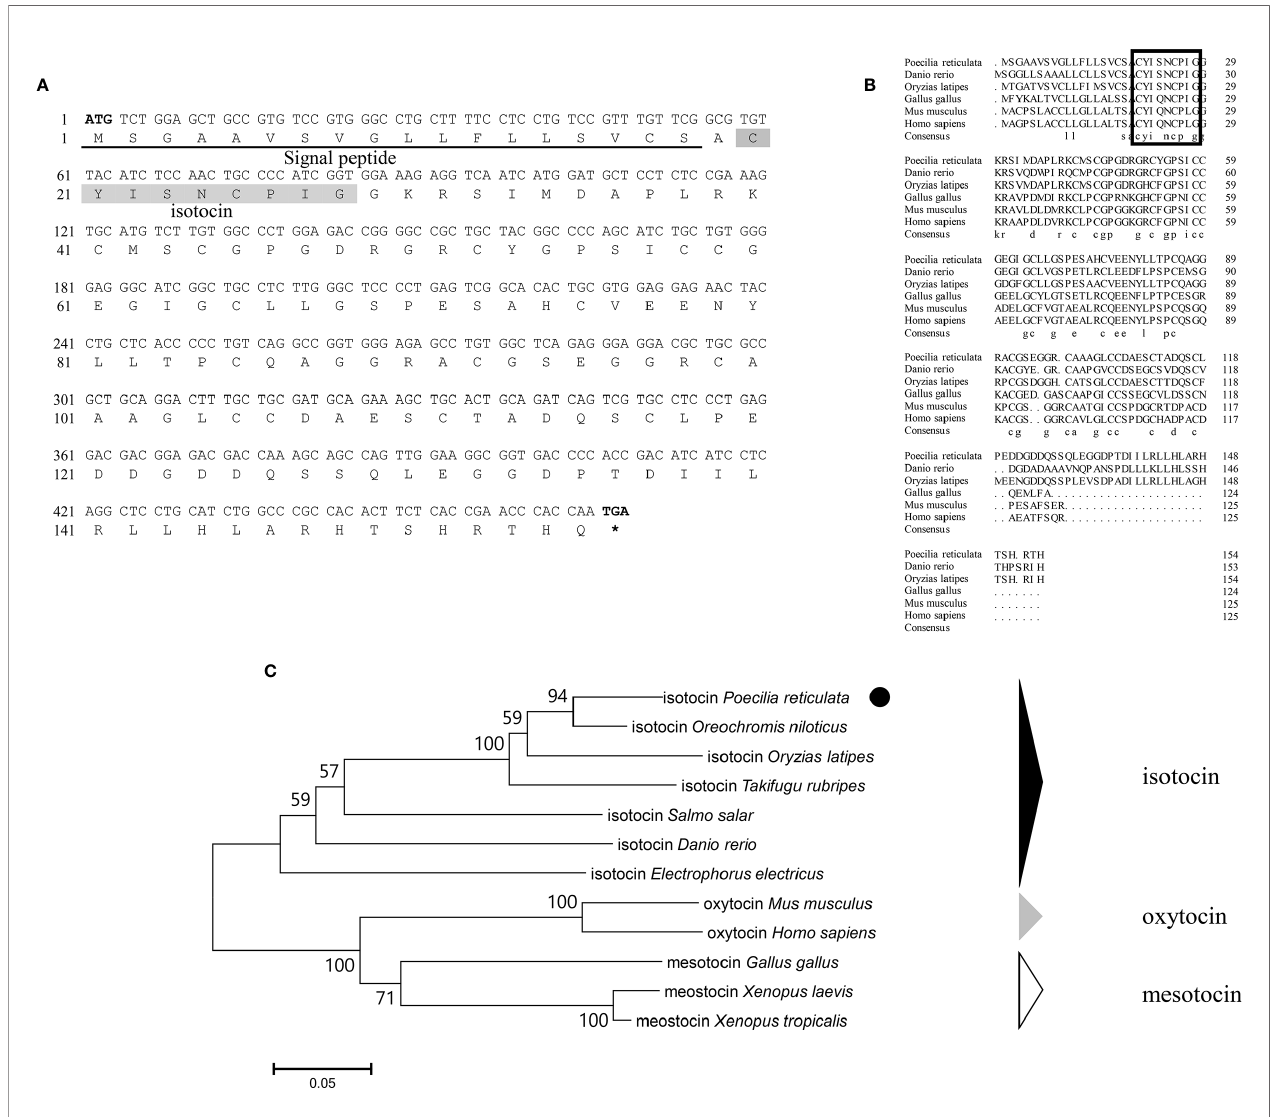
FIGURE 2 | (A) Nucleotide and deduced amino acid sequences of guppy IT. The putative signal peptide is underlined. The putative IT peptide is shaded. (B) Multiple comparisons of the amino acid sequences of OT/IT/MT precursors. The boxed letters indicate the sequence of mature OT/IT/MT. (C) Phylogenetic analysis of IT precursors in different species. The phylogenetic tree was constructed using MEGA 6 software and the neighbor-joining method. The data were resampled with 1,000 bootstrap replicates. The accession numbers of each sequence are as follows: Oryzias latipes (NP_001265759.1), Salmo salar (ABU80634.1), Takifugu